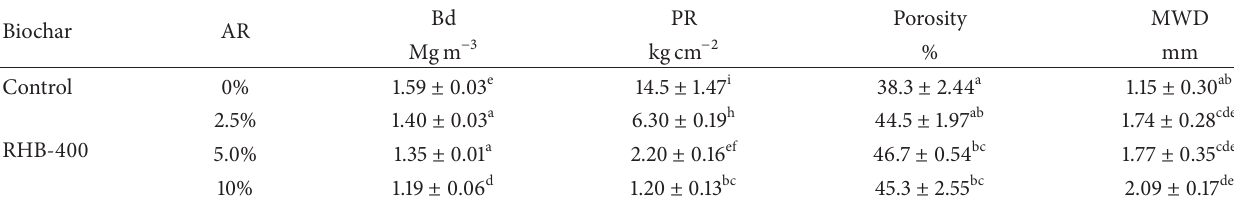
Table 2: Physical properties of the studied soil with different biochar treatments after 168 days.